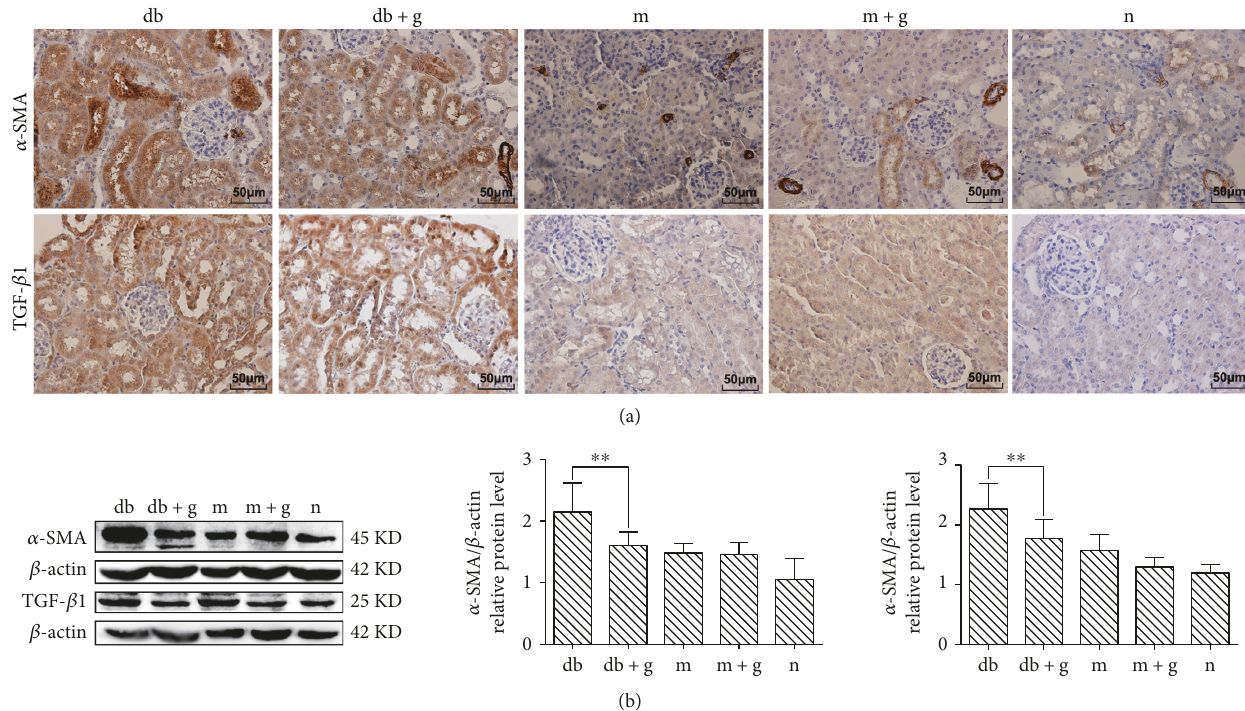
Figure 4: E ff ect of GA on the expression of α -SMA and TGF- β 1 in the renal cortex of db/db mice. (a) Immunohistochemistry was used to detect the expression of α -SMA and TGF- β 1. Original magni fi cation: × 400. (b) Western blot assays were used to detect α -SMA and TGF- β 1 in mice treated with GA. The proportion of cells with positive protein expression is shown. Histograms indicate the mean ± SD ( ∗∗ p < 0 05 ). β -actin was detected to con fi rm equal loading. The gray graph indicates the relative level of protein expression in each